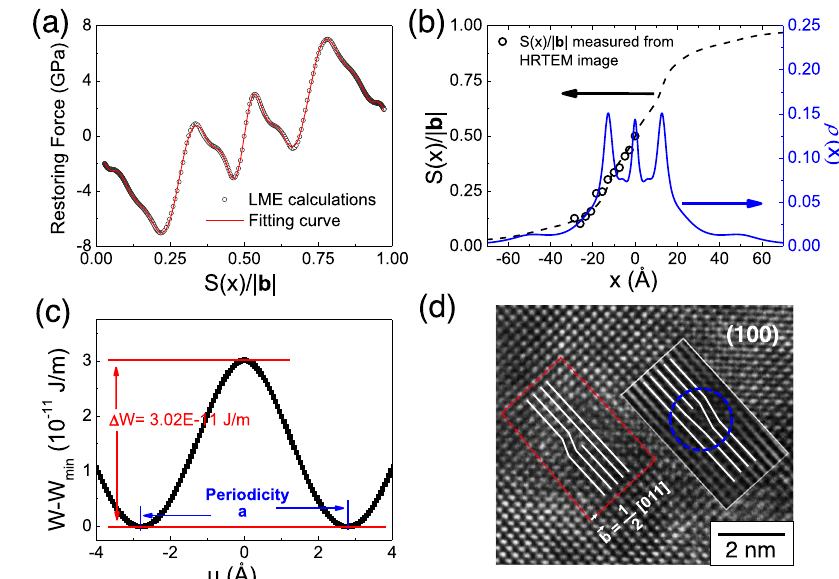
− 11J/m; d high-resolution transmission electron microscopy W min is 362.12E (HRTEM) image containing two partial 〈 011 〉 {011}-type dislocations from the